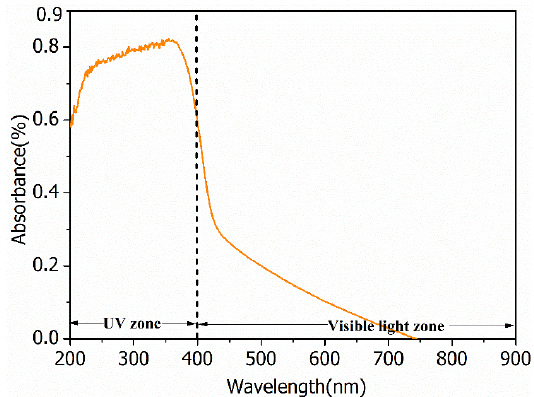
Figure 4. UV-visible diffuse reflectance absorption spectra of BiOCl-HAP SM microflowers.